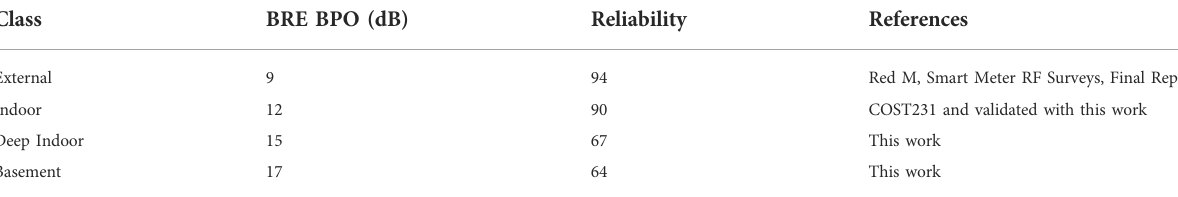
TABLE 5 Final BPL chosen and their reliance on previous